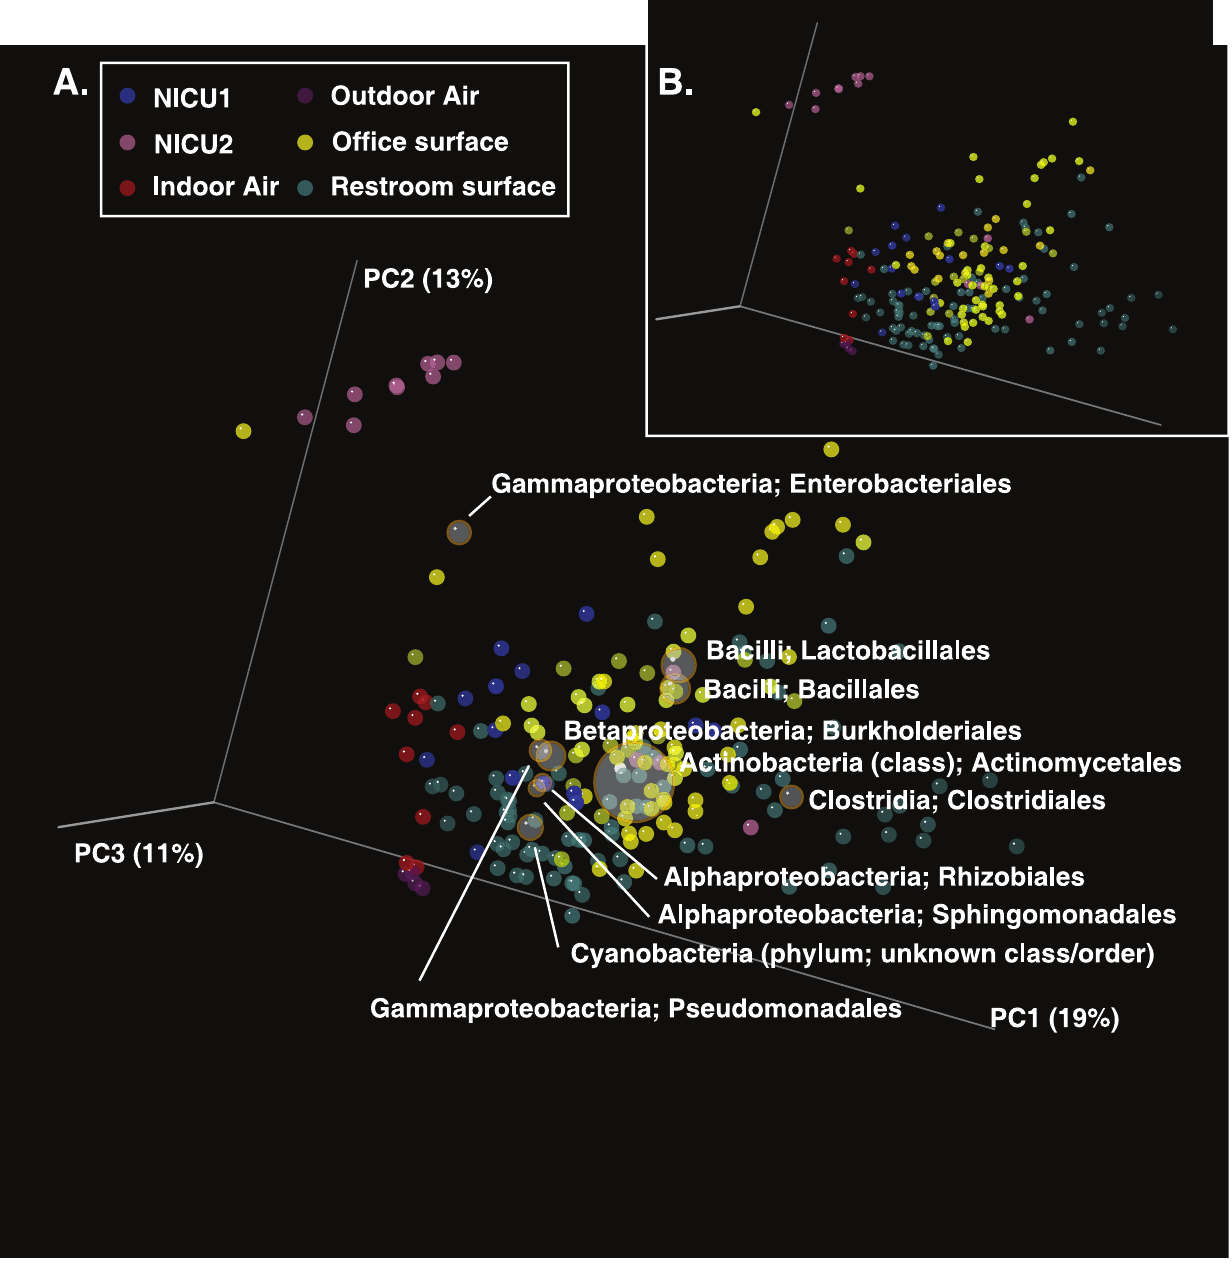
Figure 1. PCoA analysis of NICU samples and previously published indoor studies. PCoA of pair-wise weighted UniFrac distances (see Methods) both with biplots that include taxonomy (A), and without biplots (B). The different colored points indicate the various indoor sampling environments Most of the NICU samples cluster with other indoor surface samples, except for nine NICU1 samples in the top left which cluster with a single office surface sample. Order-level taxonomy illustrates that the presence of Enterobacteriales contributes to the distinct clustering of these samples.